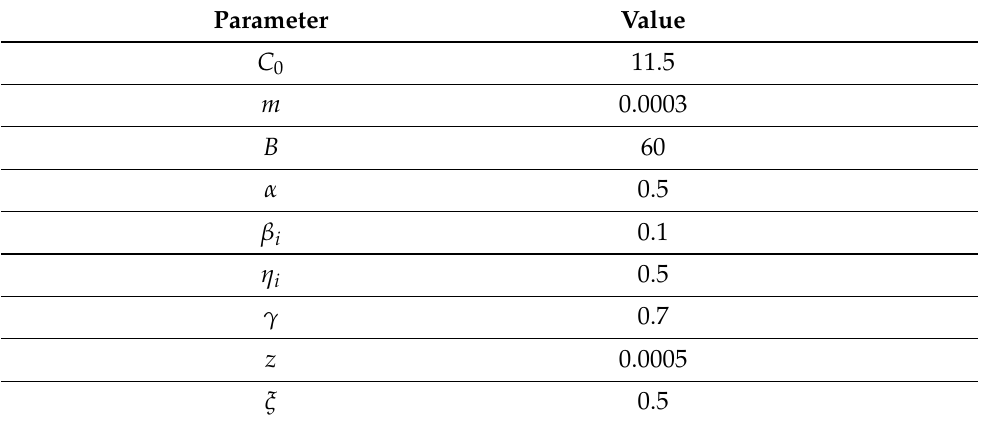
Table 1. Parameters employed in the